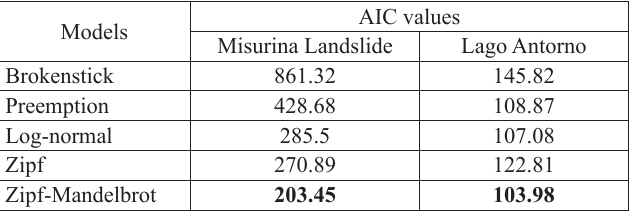
Fig. 4. Rank-abundance distributions of the bulk samples from Misurina Landslide and Lago Antorno. Table 4. Best model fit for rank-abundance distributions of the Misuri- na Landslide and Lago Antorno bulk samples. Best fit is shown in